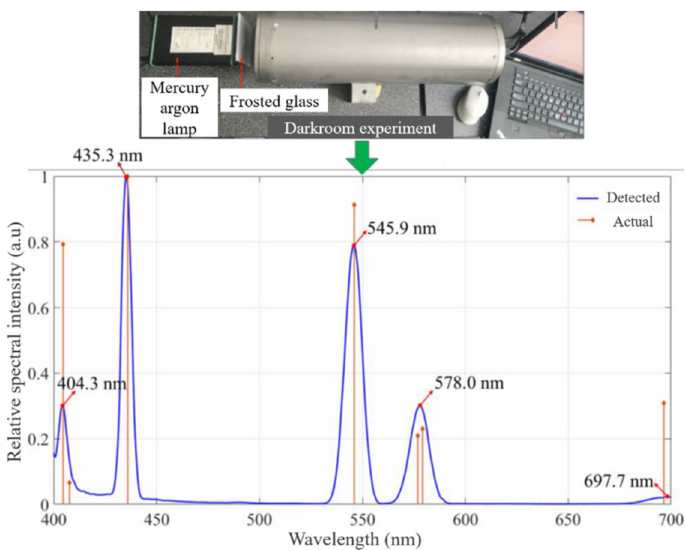
Figure 5. The relative spectral intensity distribution of a mercury argon lamp measured by USI system. The spectral intensity curve shows that the designed system can differentiate between narrowband peaks. However, the system response relies on low spectral intensity and low signal-to-noise ratio (SNR), which results in uncertainty in distinguishing the peaks at a lower